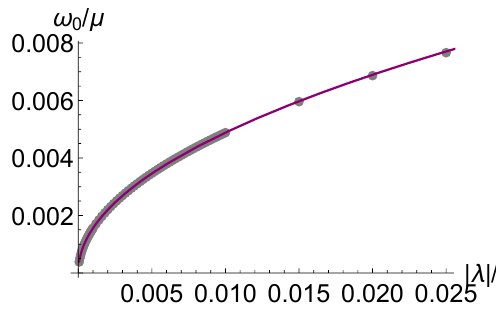
Figure 2. The pinning frequency against λ/µ at k/µ = 0 . 1 , B/µ 2 = 10 − 2 and T/µ = 5 × 10 − 2 . The solid purple line is a best fit to the data points with an expression proportional to